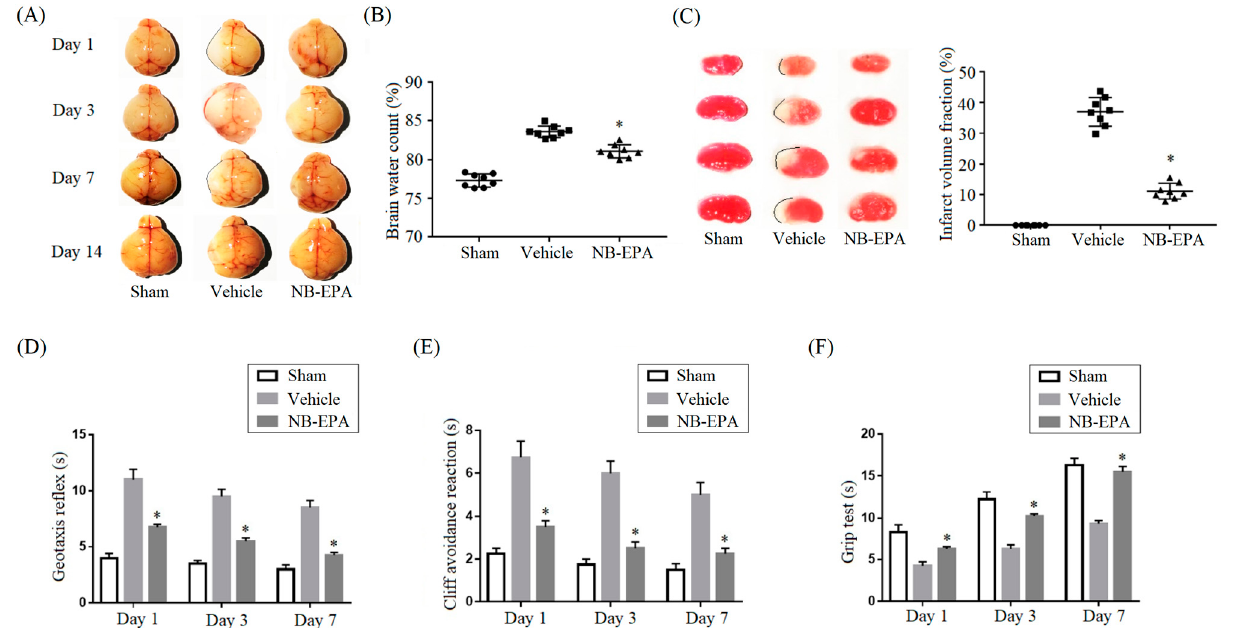
Figure 2. NB-EPA administration reduces cerebral infarction and behavioral defects in neonatal mice after HI brain injury. ( A ) Representative images of brain appearance at 1, 3, 7 and 14 days post-HI. ( B ) Statistical analysis of the brain water content from every group of mice at 3 days post-HI. ( C ) Representative photographs of TTC-stained coronal brain sections from every group of mice at 3 days after HI and quantitative analysis of the infarct volume. ( D – F ) Neurobehavioral outcomes of the geotaxis reflex ( D ), cliff avoidance reaction ( E ) and grip test ( F ) at 1, 3 and 7 days post-HI. Data are mean ± standard error of the mean (SEM) ( n = 8 per group). * p < 0.05 compared to vehicle.